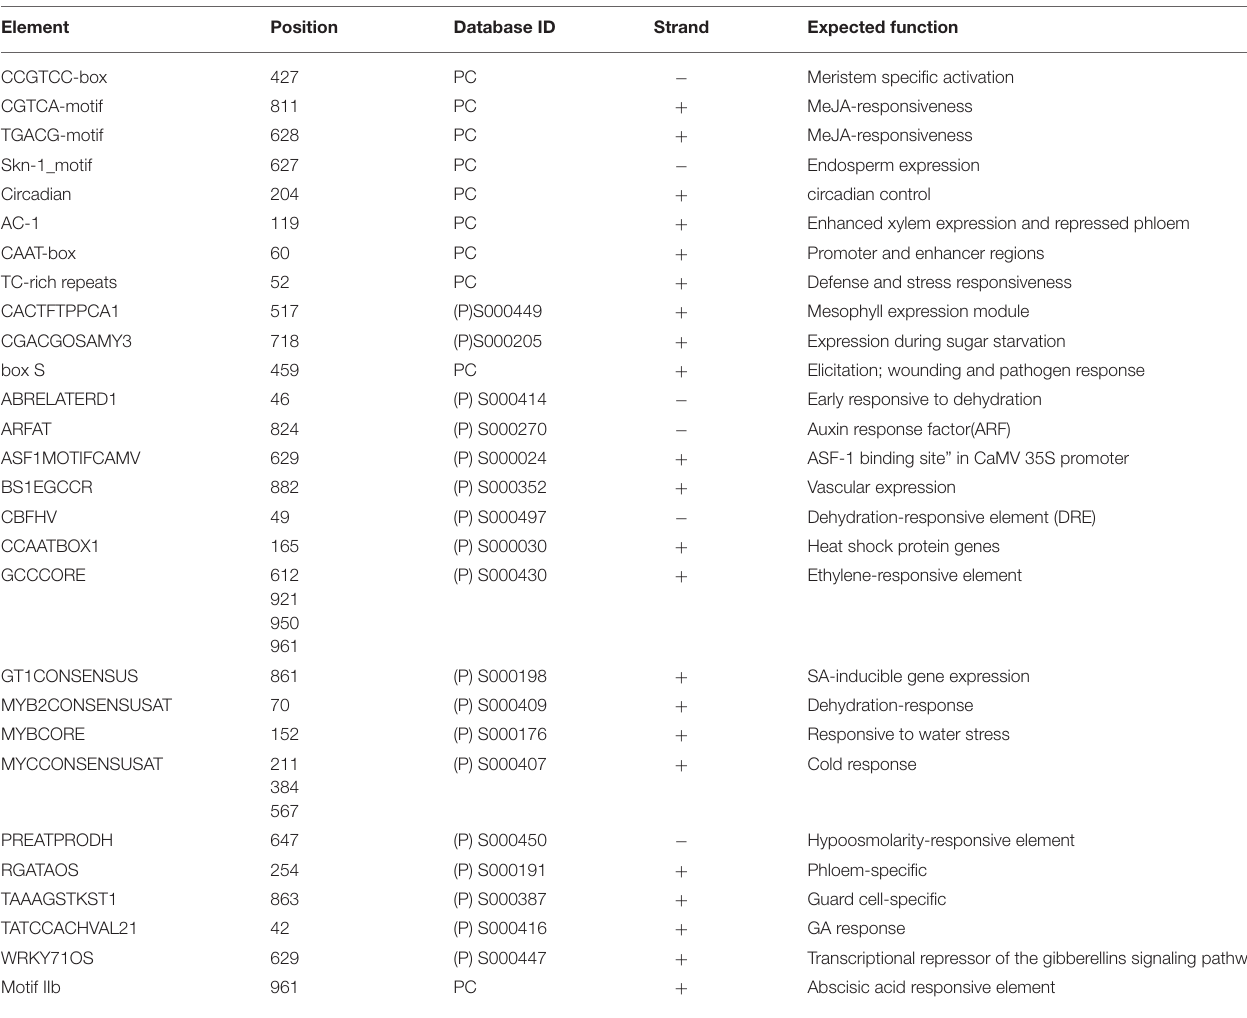
TABLE 1 | Predictions of cis-elements present in OsXPB2 promoter using PLANT CARE and PLACE database